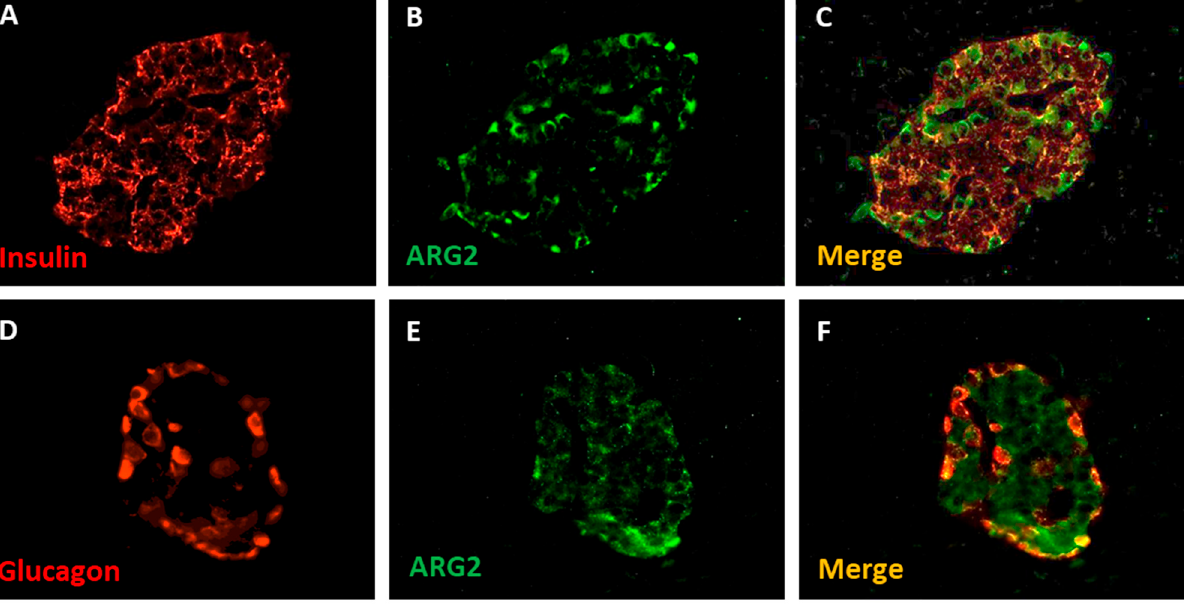
Figure 3. Immunofluorescence detection of insulin ( A ), glucagon ( D ) and ARG2 ( B , E ) in human pancreatic islet cells. The enzyme is localized in insulin-containing beta cells ( C ) and, to a lower extent, in glucagon-contaning alpha cells ( F ). Magnification 40×. Adapted from Solimena et al., 2018 [ 18 ] .